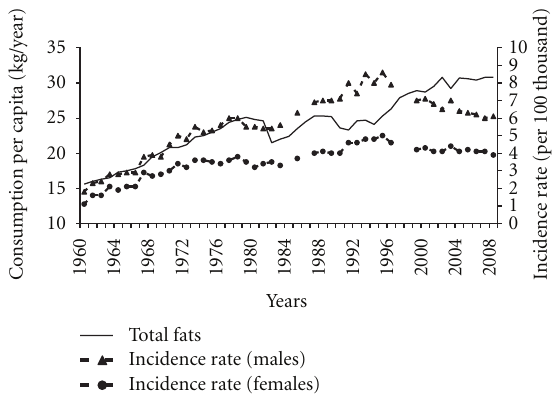
Figure 2: Total fats consumption and pancreatic cancer morbidity 1960–2008.